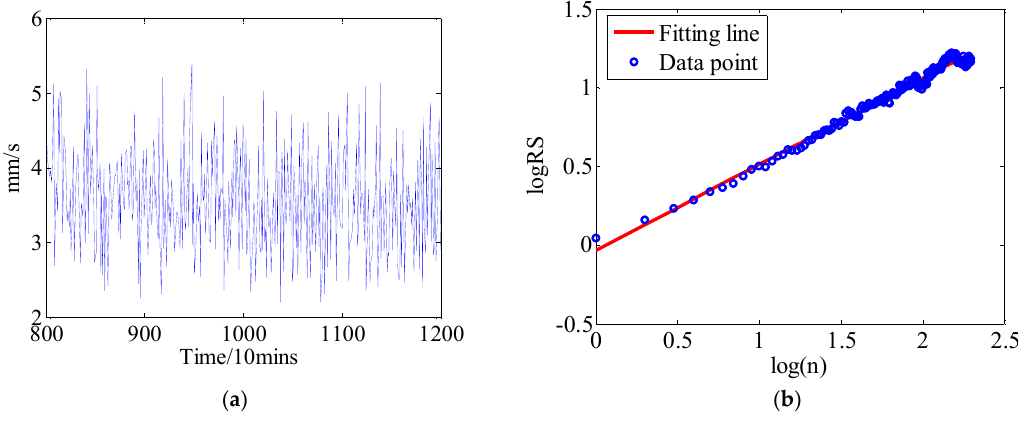
Figure 5. Weak long-range dependence (LRD) characteristic time series and its Hurst curve. ( a ) Weak LRD characteristic time series; ( b ) Hurst curve.